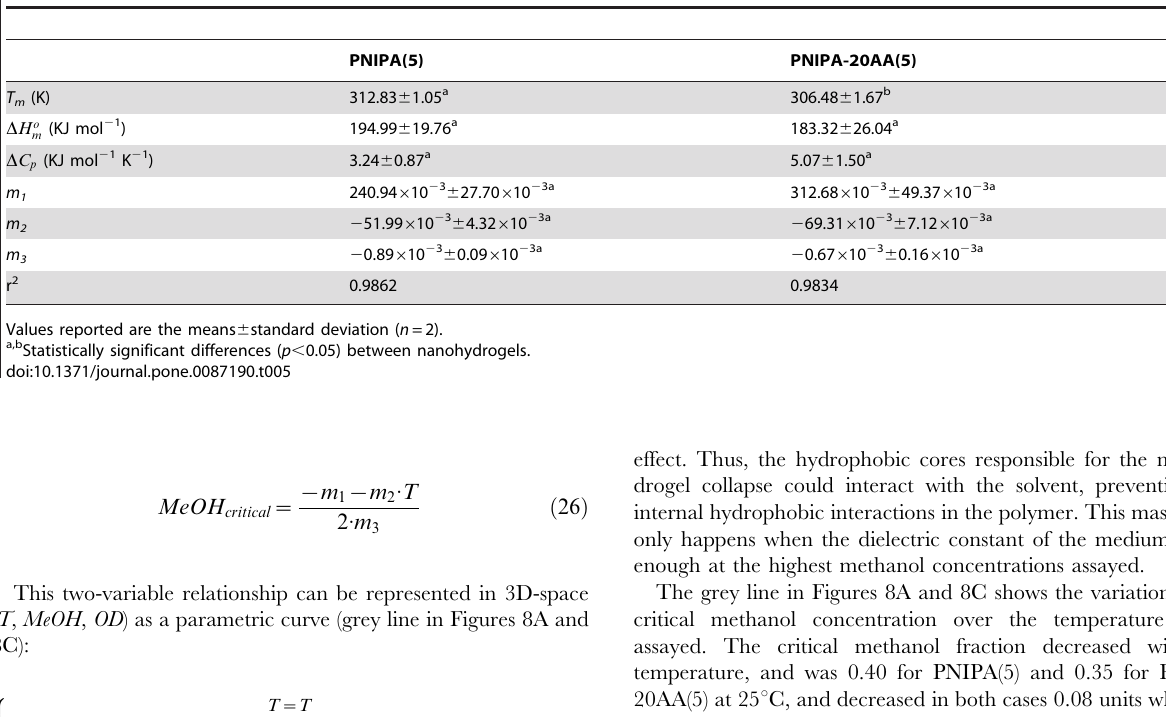
Table 5. Parameters generated from fitting the Equation 24 to experimental data of optical density variation in PNIPA/AA nanohydrogel suspensions as a function of temperature (T, K) and the methanol volume fraction (MeOH,